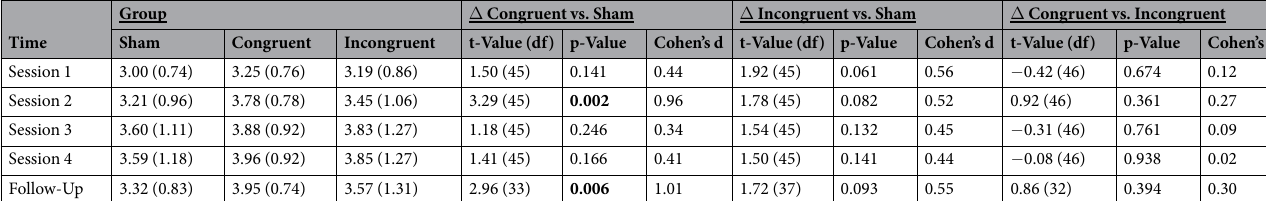
Table 1. Pairwise t-Test comparisons between groups across all training sessions. Data are mean values with standard deviations in parentheses; Comparisons are made with baseline corrected mean values ( Δ ) at respective time points.